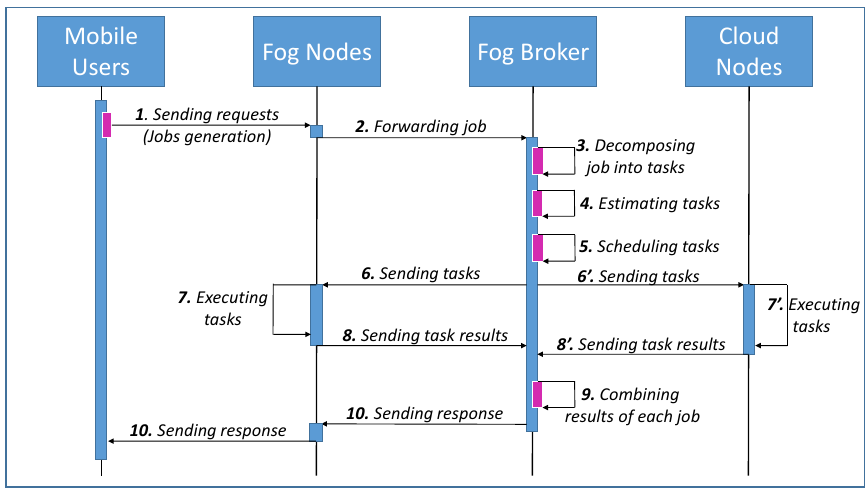
Figure 1. The operation of Cloud–Fog